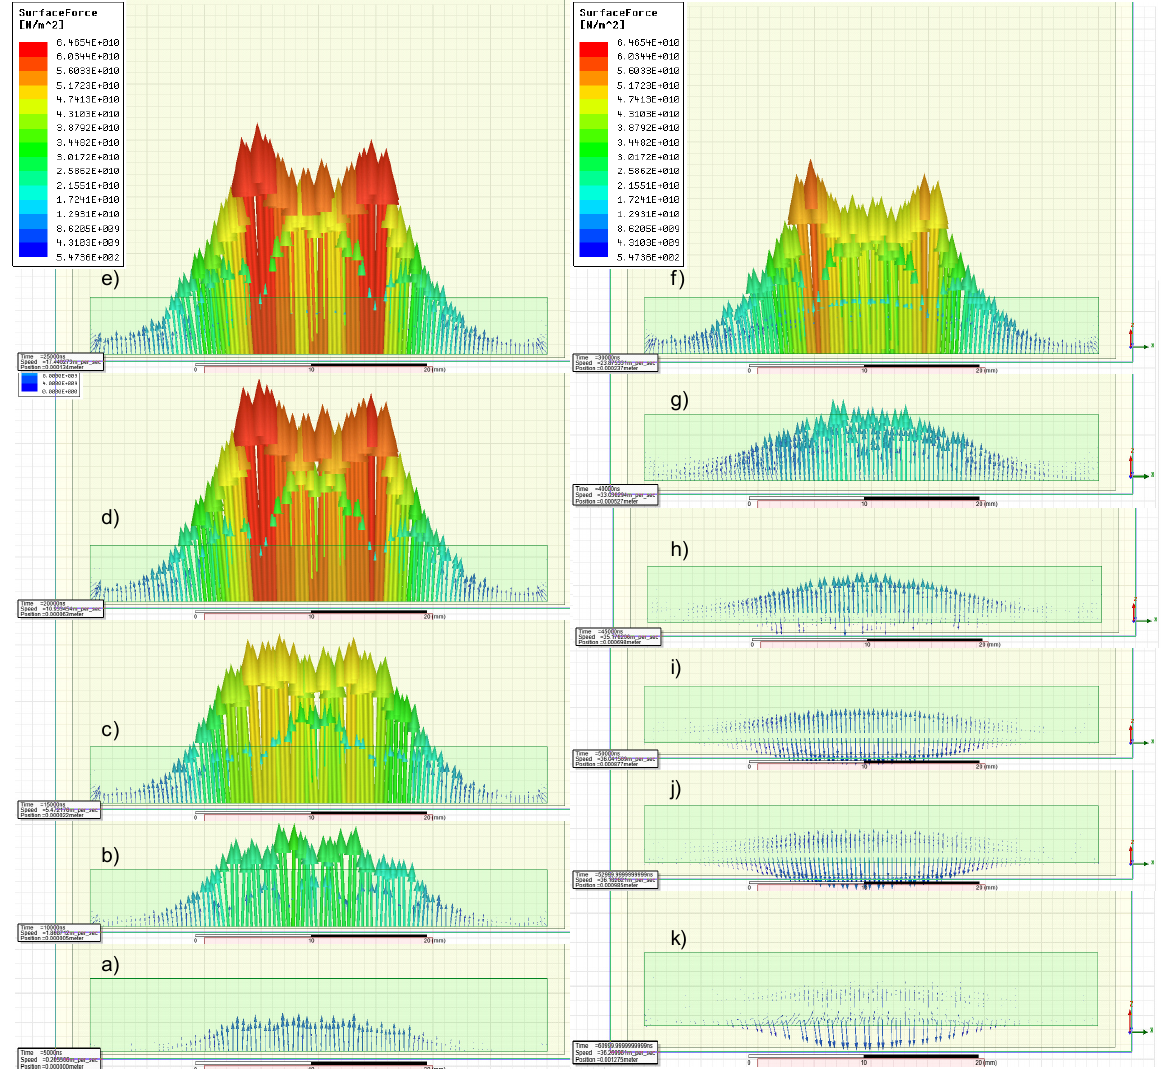
Figure 13. Screenshots of motion animation and of forces acting on each disc element: ( a – e ) increasing forces, ( f – k ) decreasing forces.